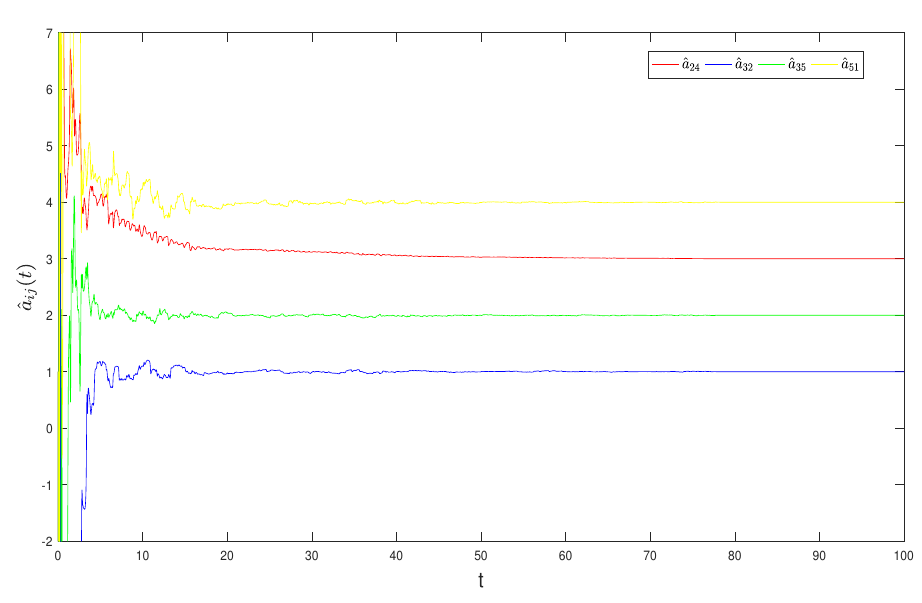
Figure 2. (Color online) The orbits of (cid:98) a 24 ( t ) , (cid:98) a 32 ( t ) , (cid:98) a 35 ( t ) and (cid:98) a 51 ( t ) .